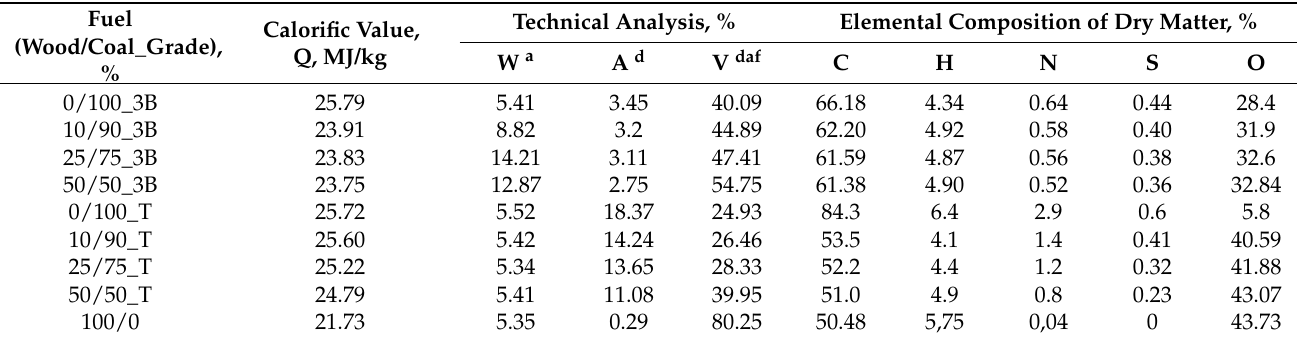
Table 1. The results of the analysis of the calorific value, the yield of volatile substances, moisture content, ash content, and elemental analysis per dry weight of the fuel mixtures under study.